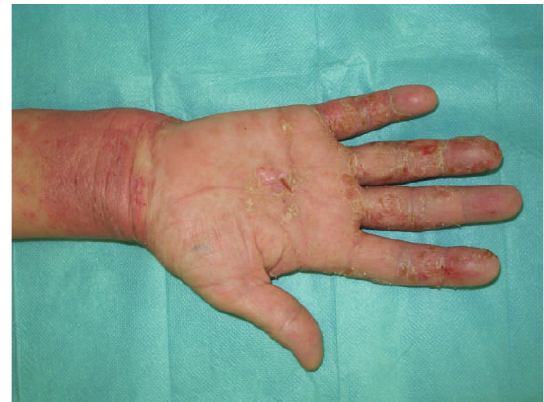
Figure 2: Hand eczema.